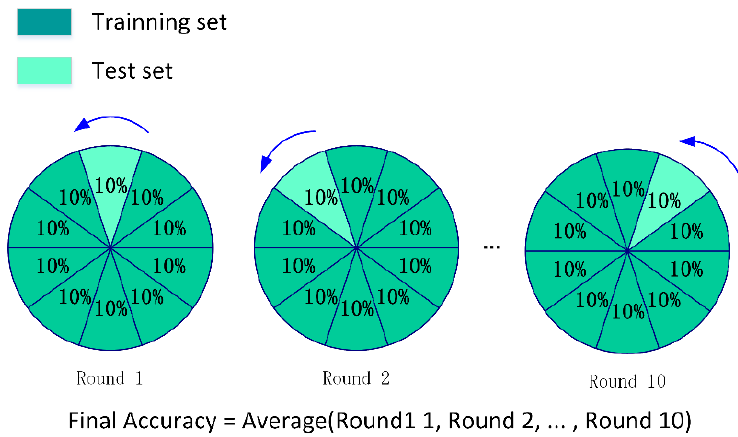
Figure 3. Schematic diagram of the tenfold cross-validation algorithm flow.